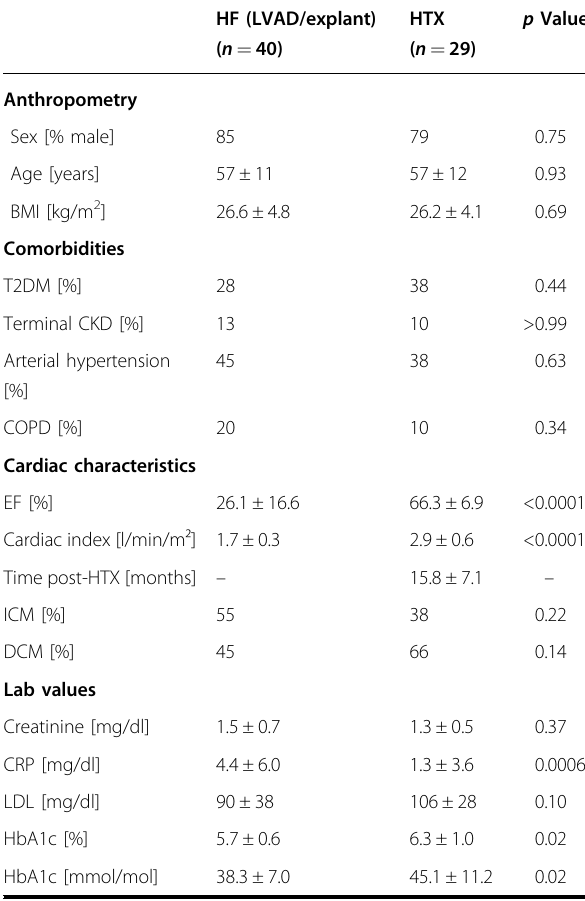
Table 1 Patient